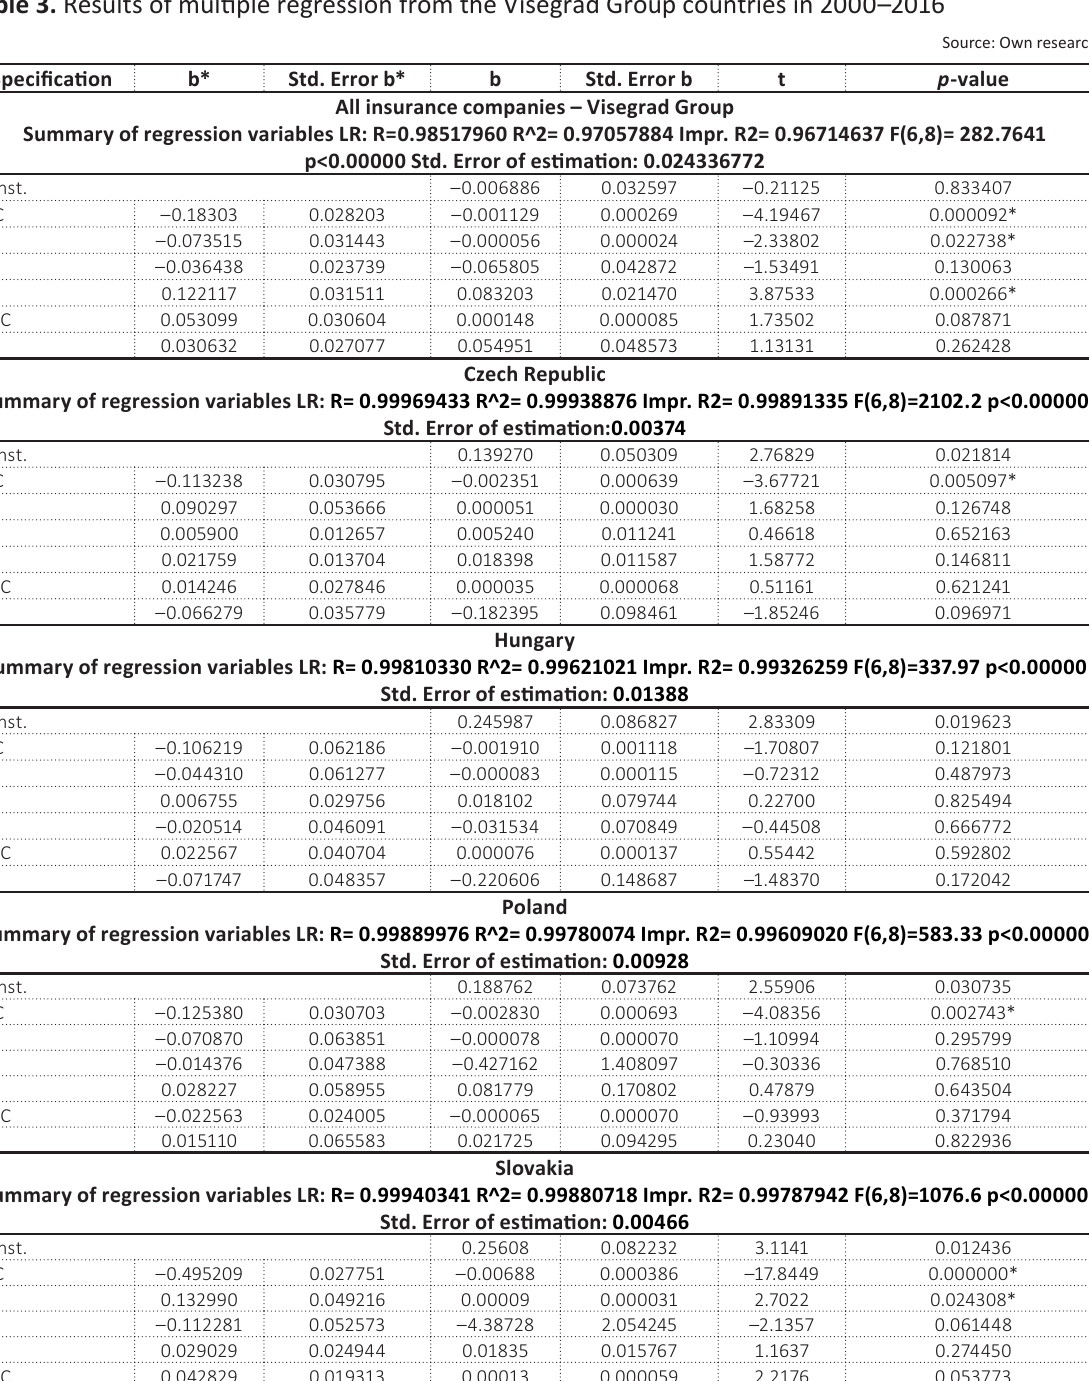
Table 3. Results of multiple regression from the Visegrad Group countries in 2000–2016